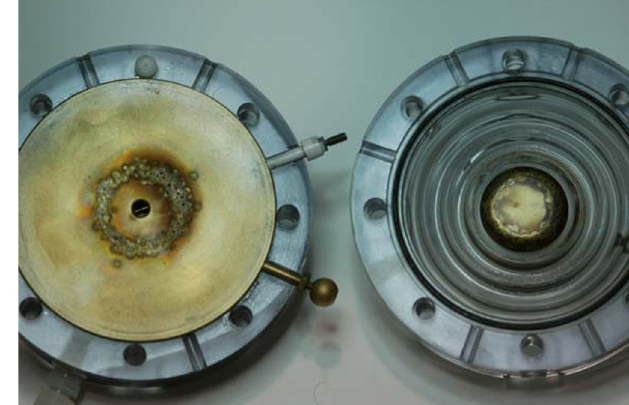
FIG. 10. (Color) L3 Communications, Pulse Sciences gas switch rated for (cid:2) 100 kV . The brass midplane with its central UV- preillumination gap is shown on the left and the cathode elec- trode is shown on the right.